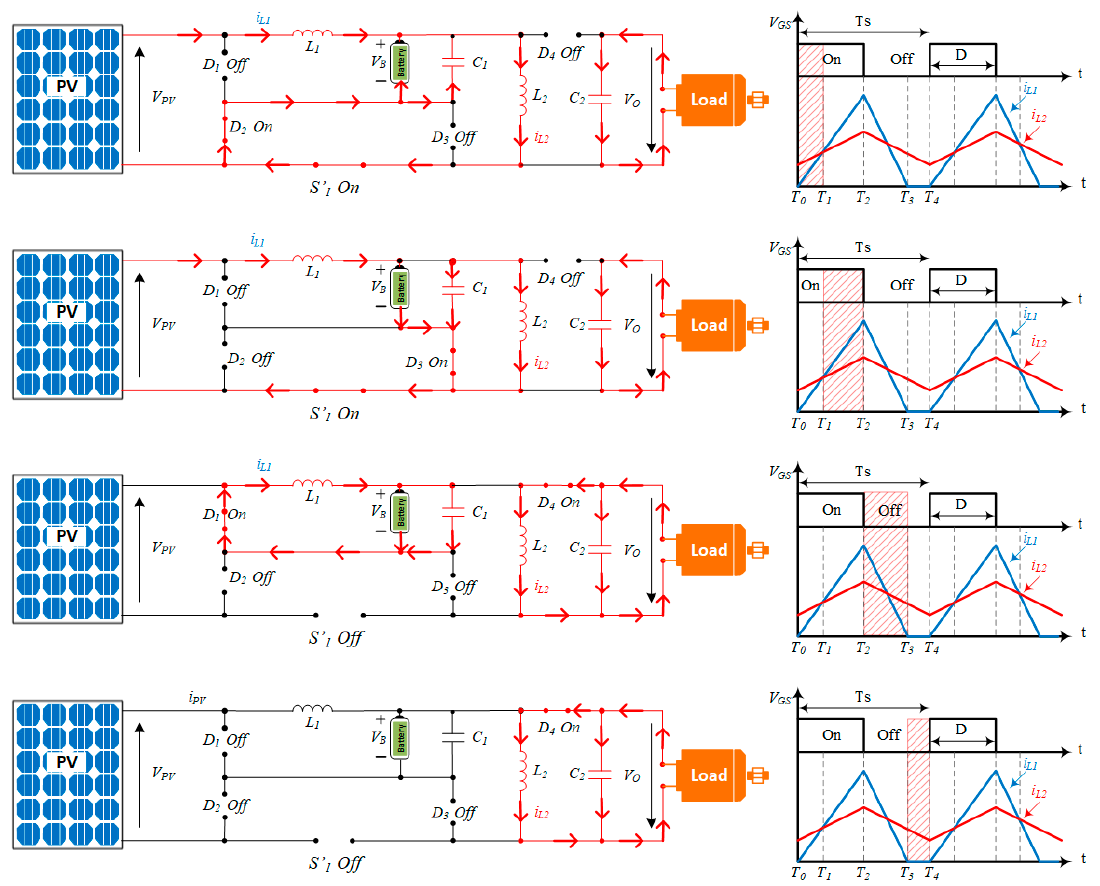
Figure 6. Principle and operation modes of the equivalent single switch circuit.